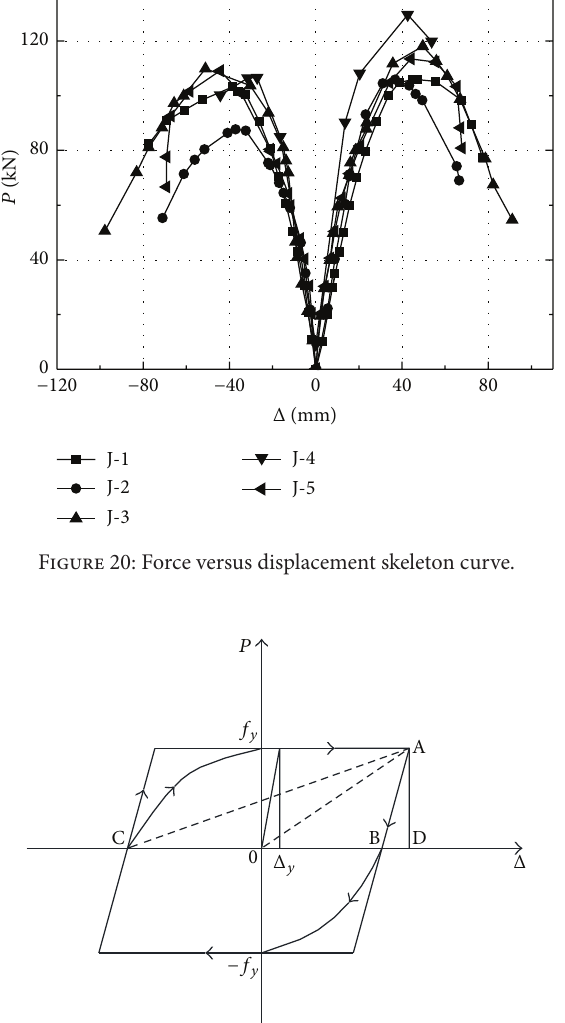
shear failure, all five test specimens showed a stable over- all response to cyclic load reversals. The average value of displacement ductility reached 3.59. The joints had good structural performance with stable and ductile hysteresis behavior upon attaining their maximum strength with little deterioration of